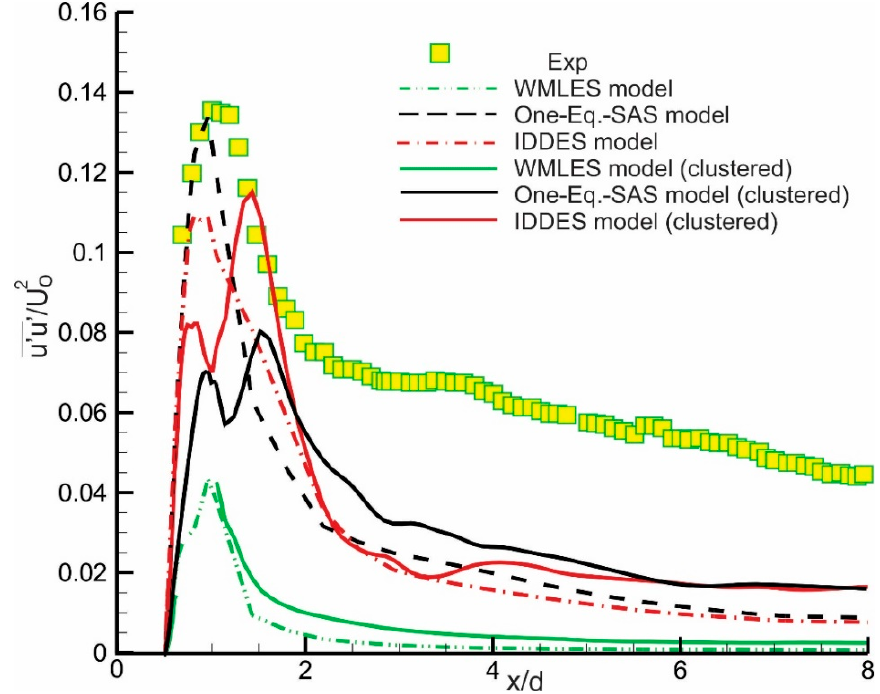
′ ′ 2 ′ ′ 2 on the centerline behind the cylinder in u u /U on the centerline behind the cylinder u u /U on the centerline behind the cylinder b b b